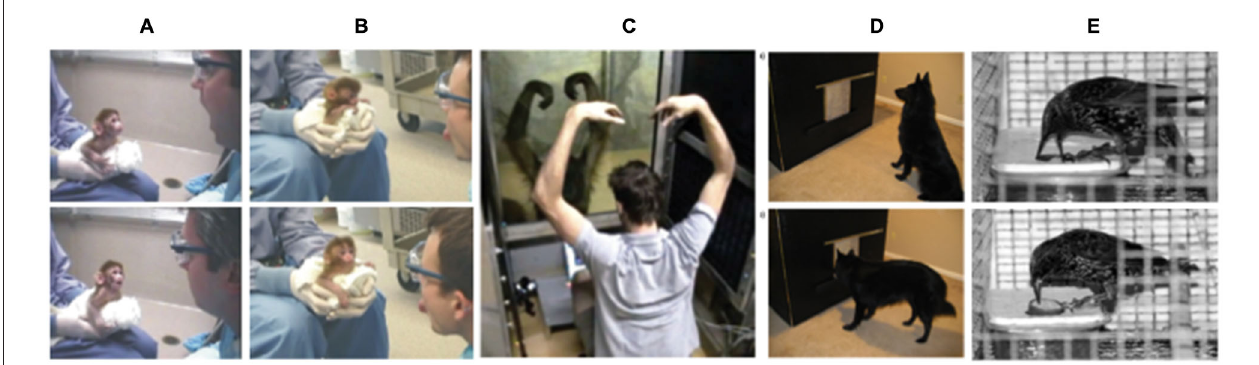
Apparatus with dog at the start of a test trial (top panel), and apparatus as dog is starting to make a screen-push response as test for imitation (bottom panel) (reprinted from Miller et al. (2009) with permission from Elsevier). (E) Starlings engaging in a two-action method task for imitative learning, with a push demonstrator (top panel) and a pull demonstrator (bottom panel) (reprinted from Fawcett et al. (2002) with permission from